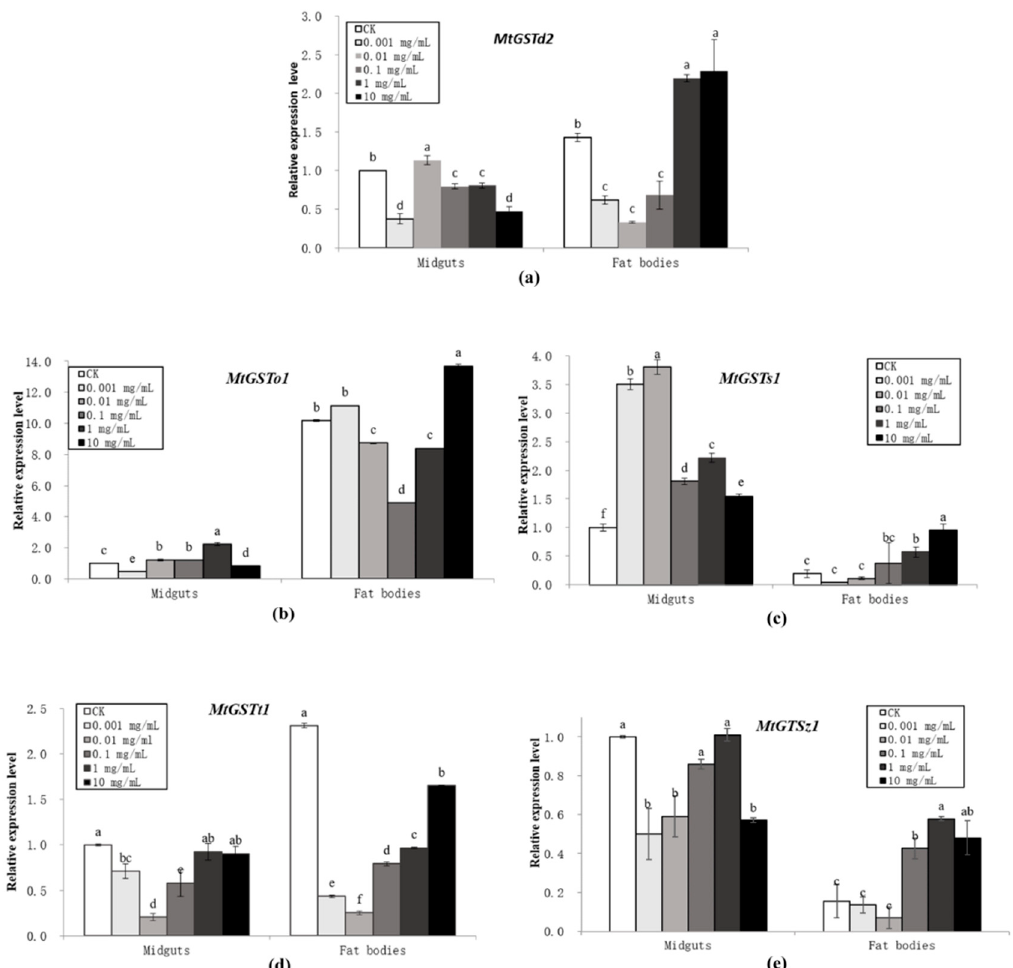
Figure 2. Quantification of relative expression of the five GST genes in M. troglodyta exposed to double-distilled water as a control (0) and to tannic acid at five different concentrations (0.001, 0.01, 0.1, 1, and 10 mg/mL) at 96 h posttreatment ( a ) MtGSTd2 ; ( b ) MtGSTo1; ( c ) MtGSTs1; ( d ) MtGSTt1; ( e ) MtGSTz1.